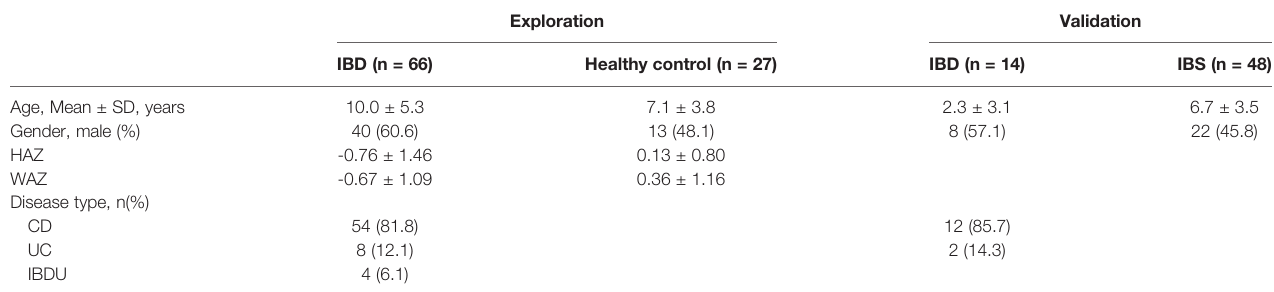
TABLE 1 | Demographic characteristics of study subjects at diagnosis.